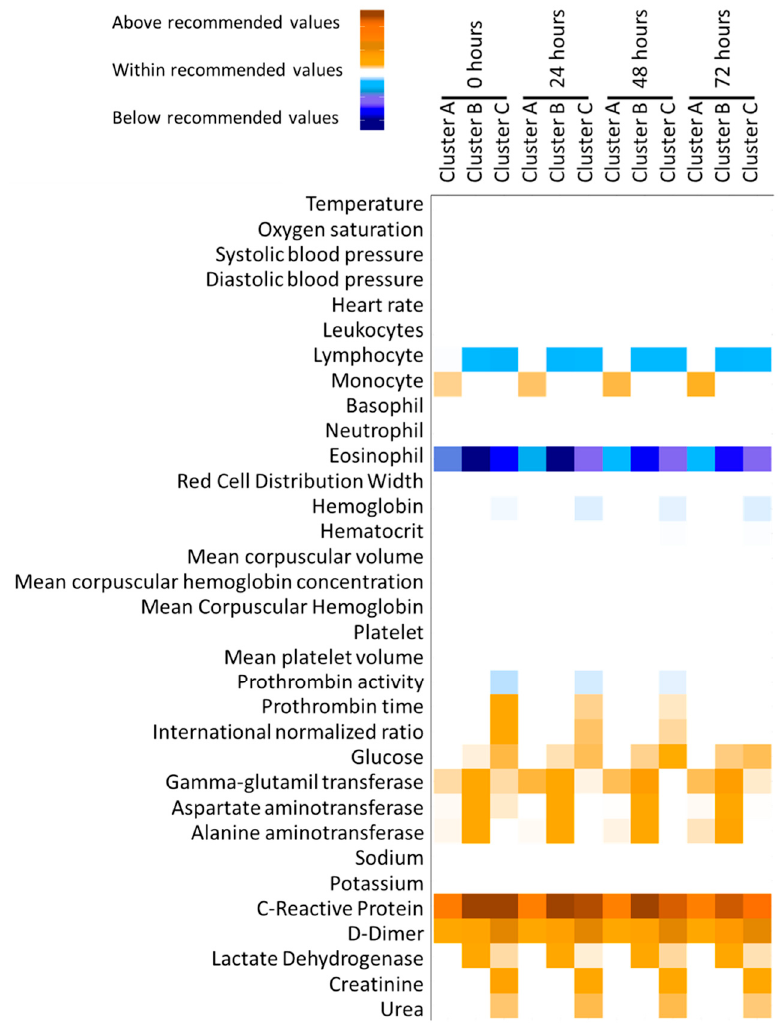
Figure 1. Heatmap plot of adequacy to reference values for clinical variables included in the cluster analysis. White means that the mean value for the cluster was within the recommended values; meanwhile, blue and orange intensity represent the deviation from the recommended values below and above,